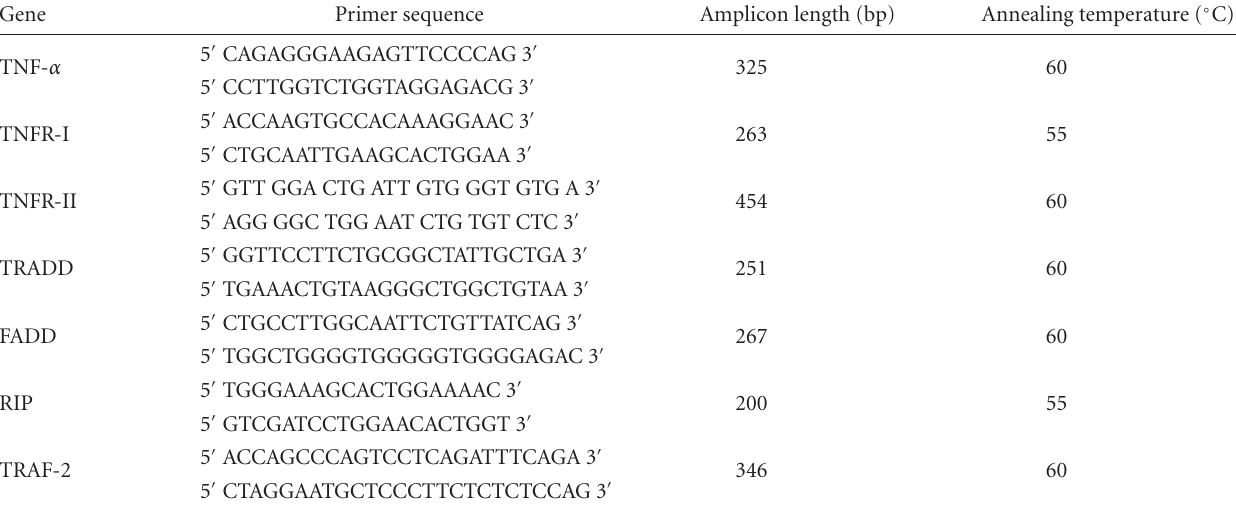
Table 1: Primer sequences specific for the TNF- α and TNF- α mediated signaling genes used for the amplification of cDNA prepared from the PBMCs of 27 RA patients and 30 healthy